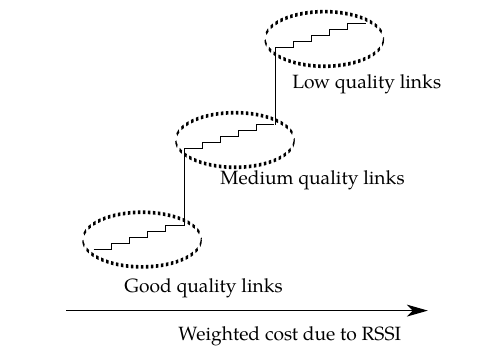
Figure 23. Weighted cost due to RSSI Range